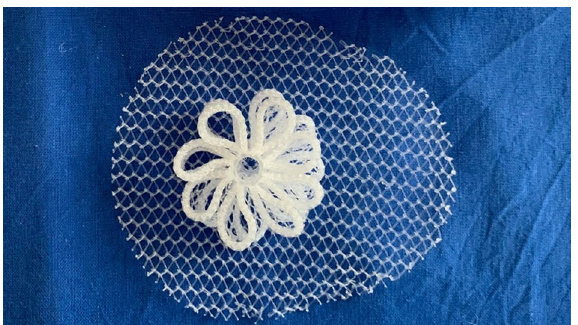
Figure 1. Regenerative scaffold ProFlor E with 40 mm sized multilamellar 3D core and 8 × 10 cm oval flat mesh connected at the center of the posterior